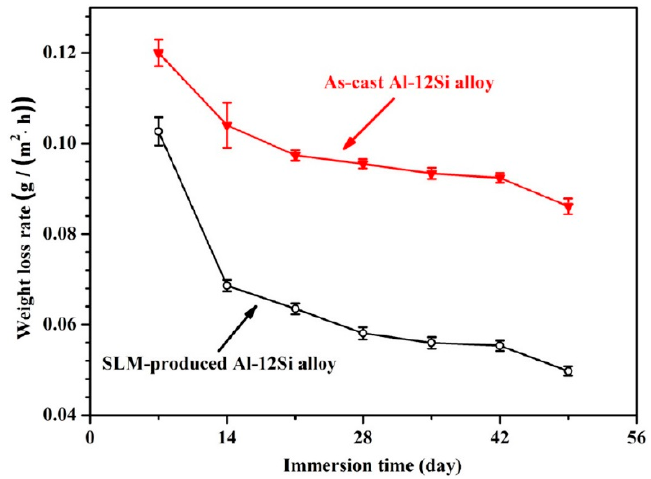
Figure 4. Weight loss rate of the SLM produced Al-12Si and casted Al-12Si after immersion in the aerated 3.5 wt. % NaCl solution [64].